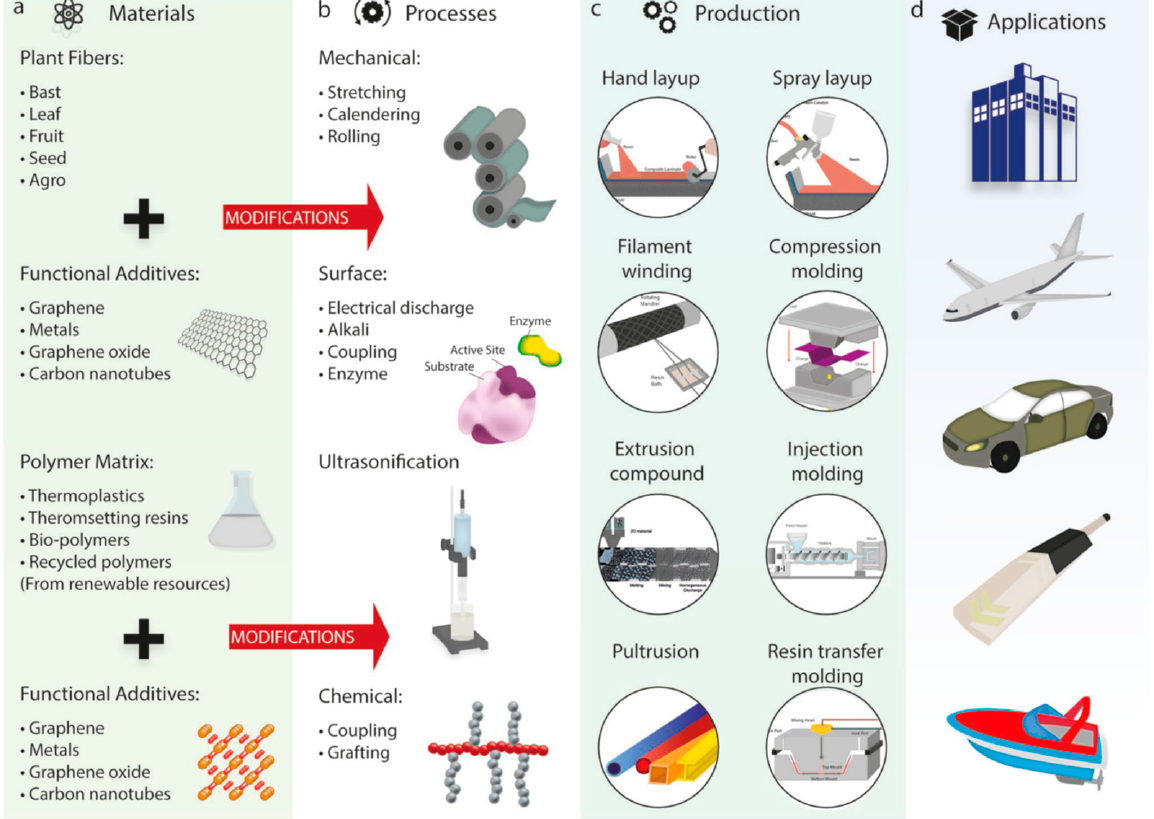
Figure 8. Sustainable FRP composites: ( a ) materials, ( b ) modification processes, ( c ) composite manufacturing methods, and ( d ) applications of fibre-reinforced composites [55] .